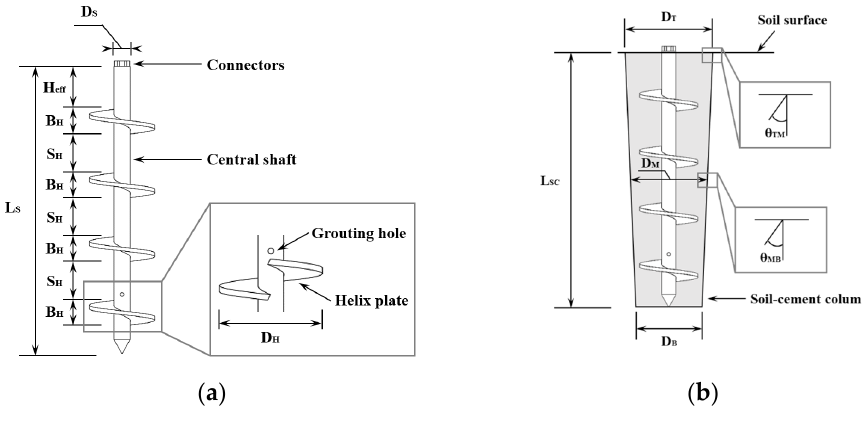
Figure 1. Conceptual drawing of model piles: ( a ) HP, ( b ) PGHP.